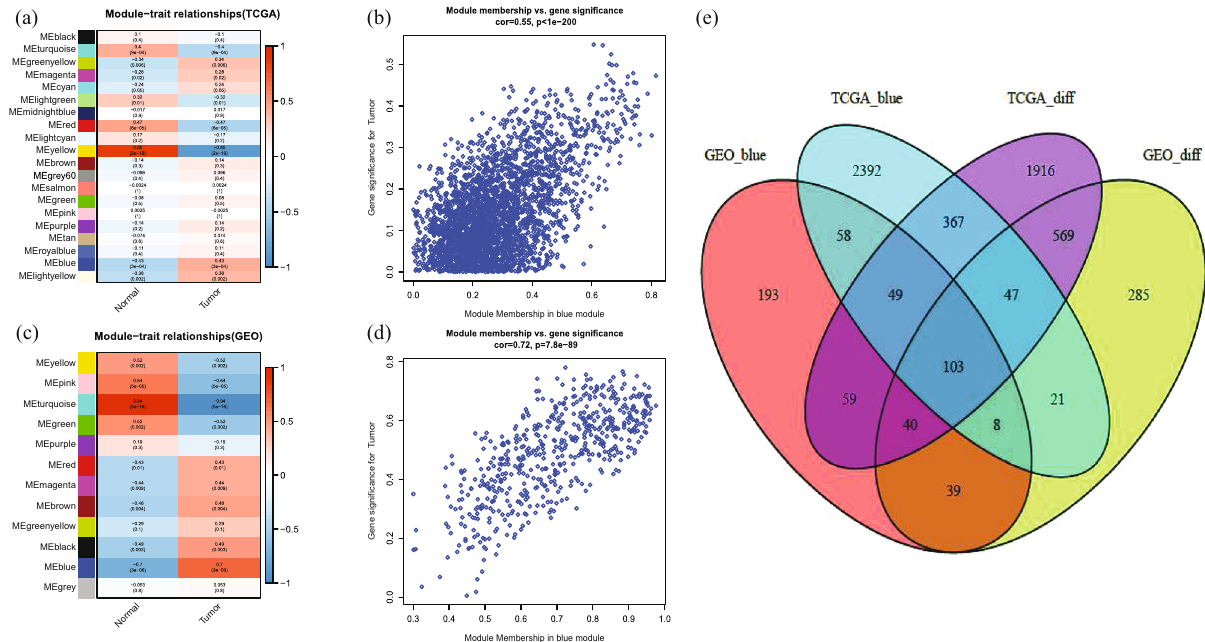
Figure 3: TCGA module - trait analysis ( a ) and module genes screen ( b ) . GEO module - trait analysis ( c ) and module genes screen ( d ) . ( 3 ) the key di ff erential expression gene set ( e ) . genes were plentiful in the spindle, chromosomal area, and chromosomal centromeric region of the chromosome. The molecular function was enriched in microtubule - binding, ATPase activity, and tubulin binding ( Figure 4a ) .